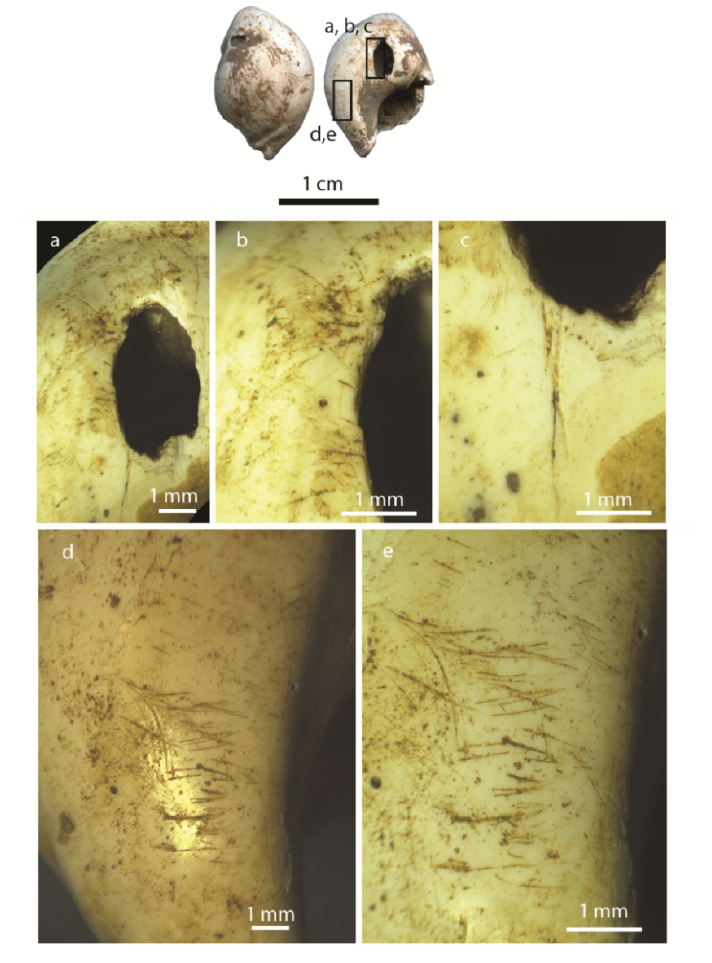
Figure 6: Short striations present around the perforation of the Tritia gibbosula (a-c) and use-wear on the ventral side close to the aperture (d,